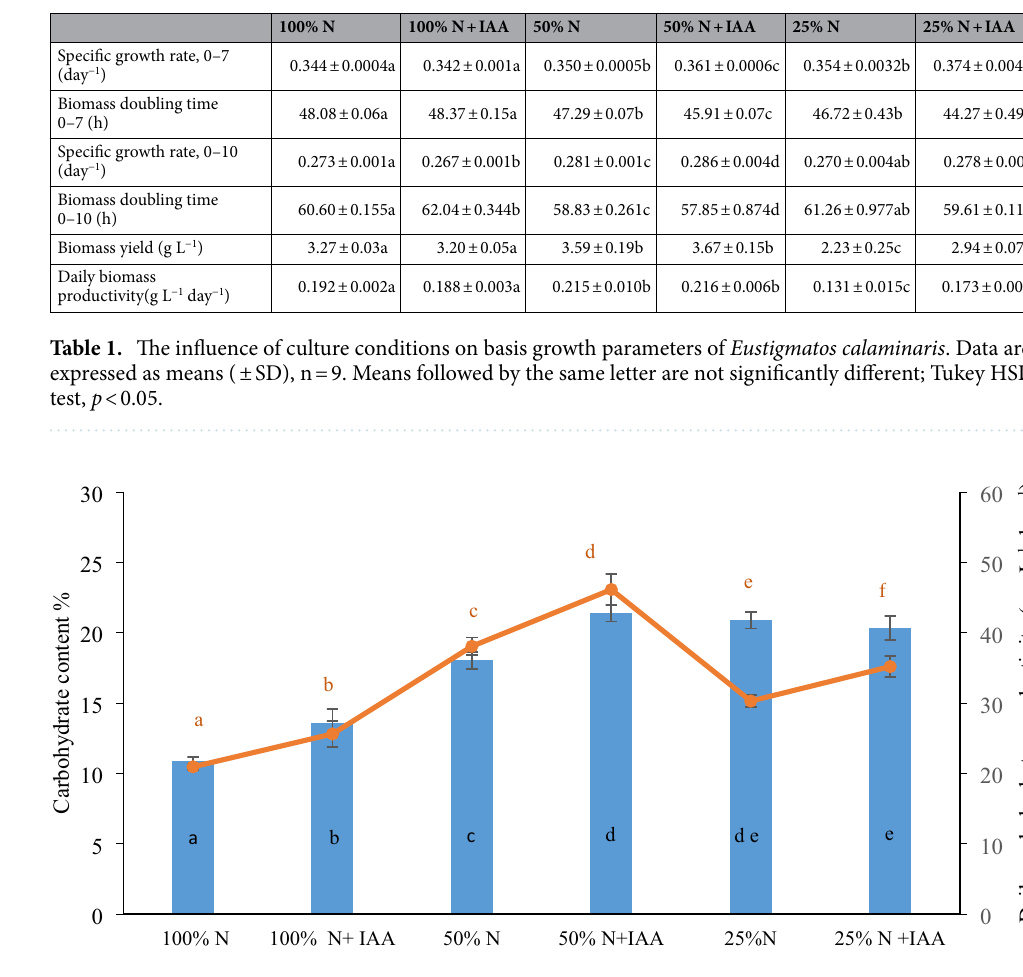
Figure 2. Impact of culture conditions on carbohydrate content (bars) and daily carbohydrates productivity (circles) in Eustigmatos calaminaris. Data are expressed as means (± SD), n = 9. Means followed by the same letter are not significantly different; Tukey HSD test, p <